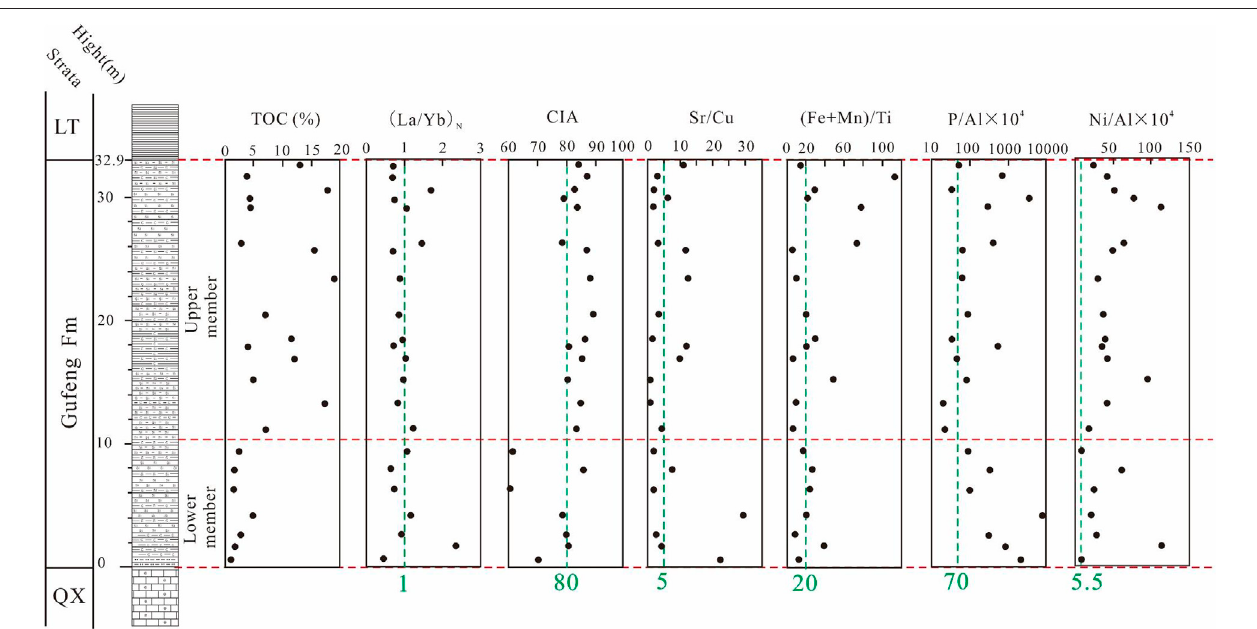
FIGURE 4 | Pro fi les of TOC, (La/Yb) N , CIA, Sr/Cu, (Fe + Mn)/Ti, P/Al, and Ni/Al from the shale samples in the Gufeng Formation at the Putaoling section. QX, Qixia Formation; LT, Longtan Formation.